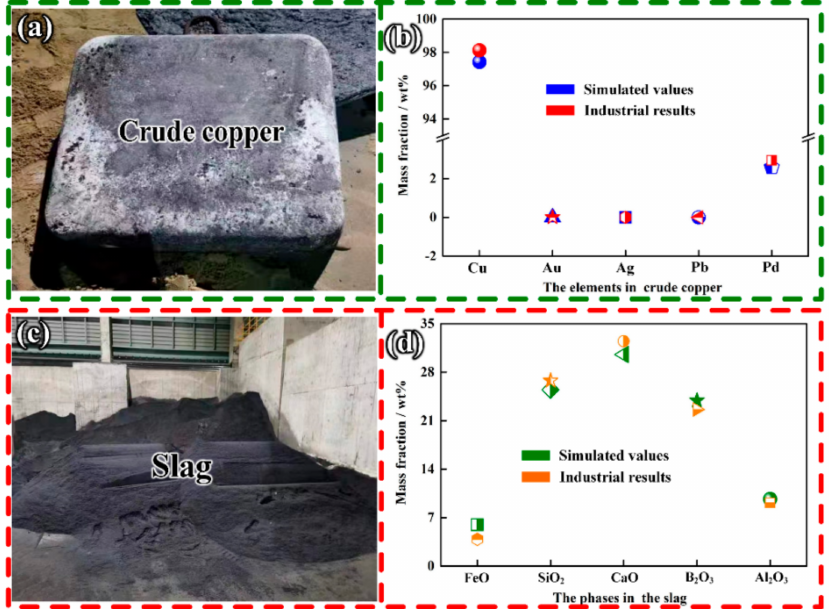
Figure 8. Verifications between the industrial results and simulated results: ( a ) The picture of the crude copper; ( b ) the comparison of various elements in the crude copper; ( c ) the photograph of the slag; ( d ) the comparison of different phases in the